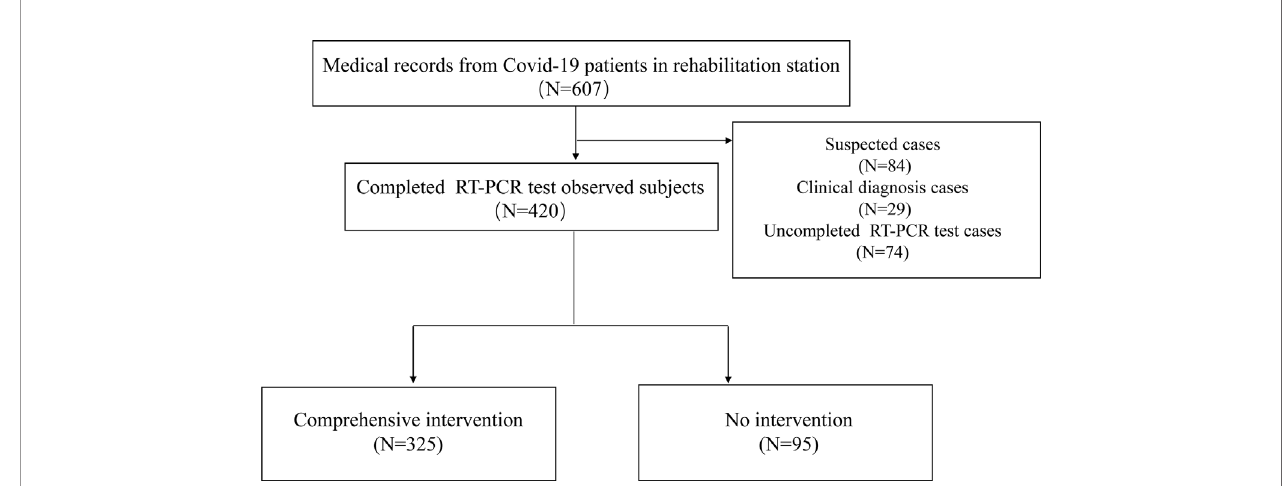
FIGURE 1 | Flow chart of the observational